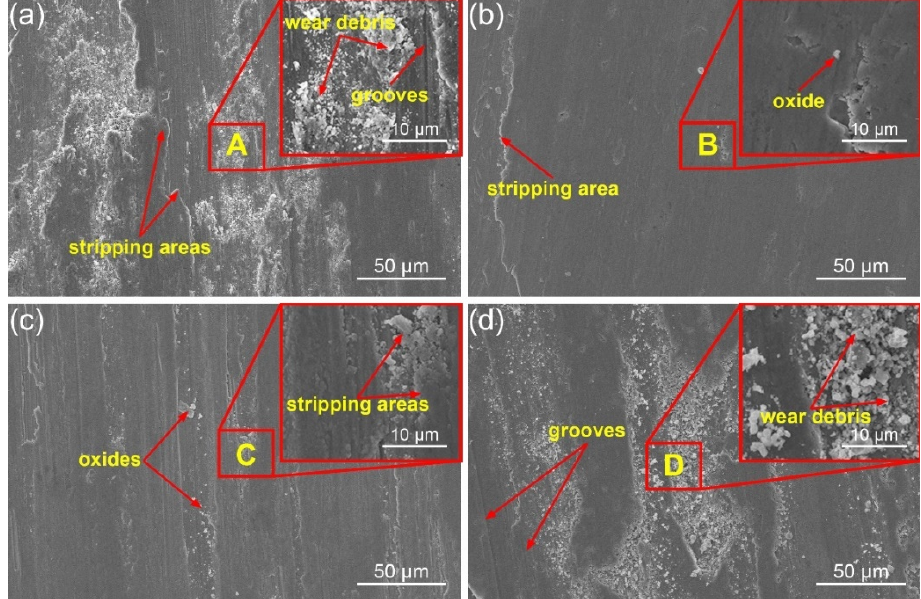
Figure 4. Wear track microstructure of samples under different conditions: ( a ) 300 °C–5 N, ( b ) 300